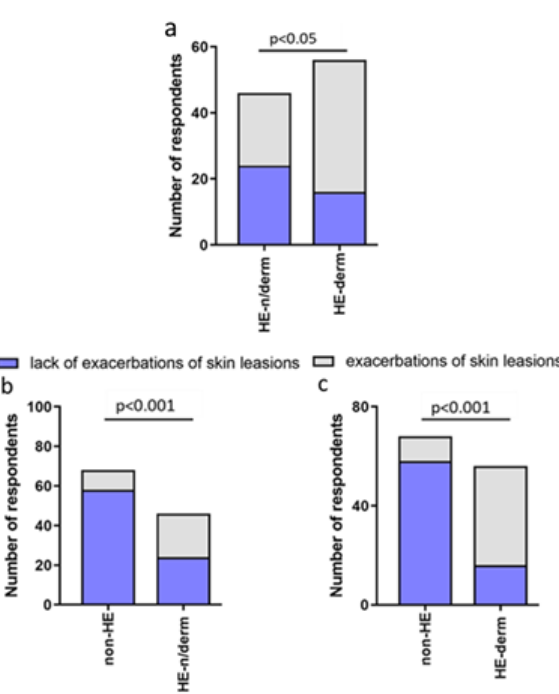
Figure 12. Comparison of the frequency of exacerbations of skin lesions during the pandemic in study groups: ( a ) HE-n/derm vs. HE-derm; ( b ) non-HE vs. HE-n/derm; ( c ) non-HE vs. HE-derm.